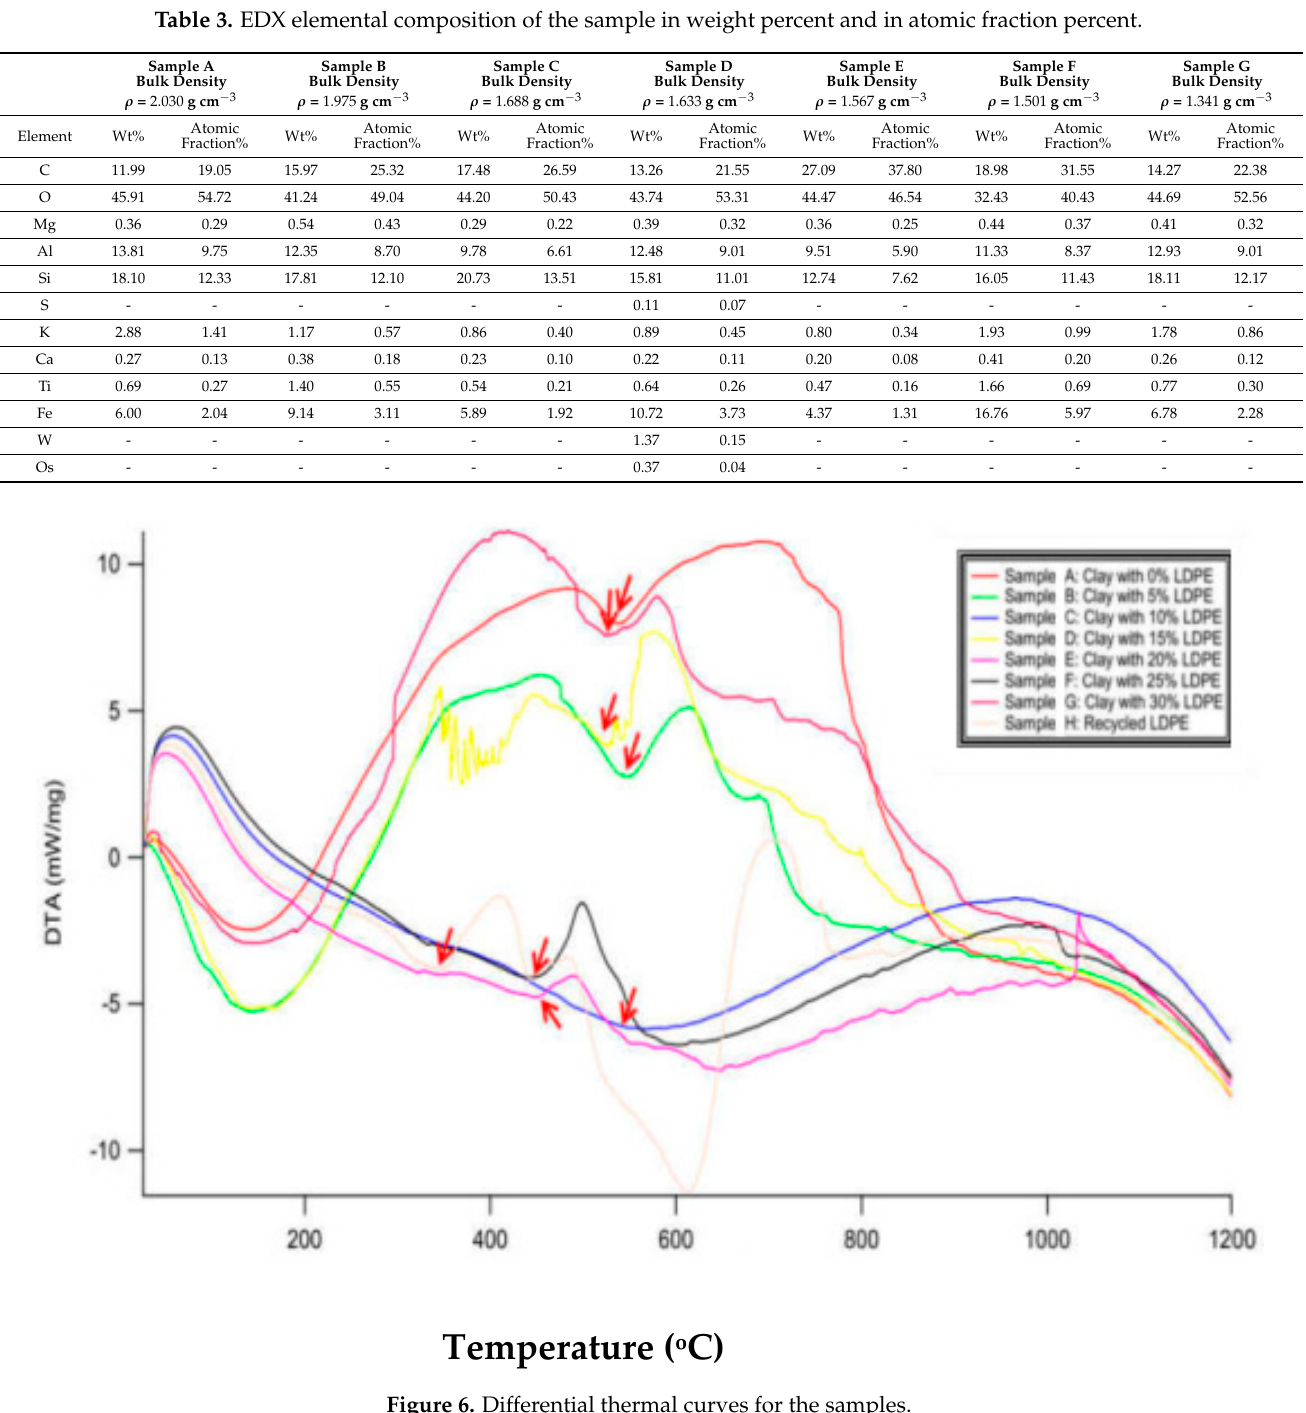
Temperature ( o C) Figure 6. Differential thermal curves for the Figure 6. Differential thermal curves for the samples